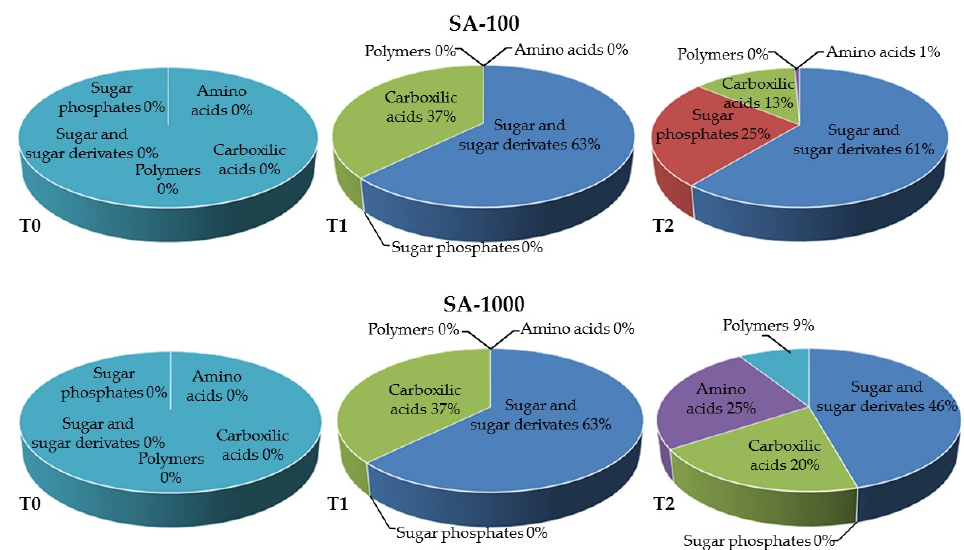
Figure 6. Use of different C-source guilds by microbial communities in amended and unamended Sb-polluted SA soils. Average percentage values relative to the 120 h incubation time are reported. T0, T1 and T2 refer to MSWC addition, i.e., 0, 1 and 2%, respectively. For overall metabolic activity of the different microbial communities see Figure 4.